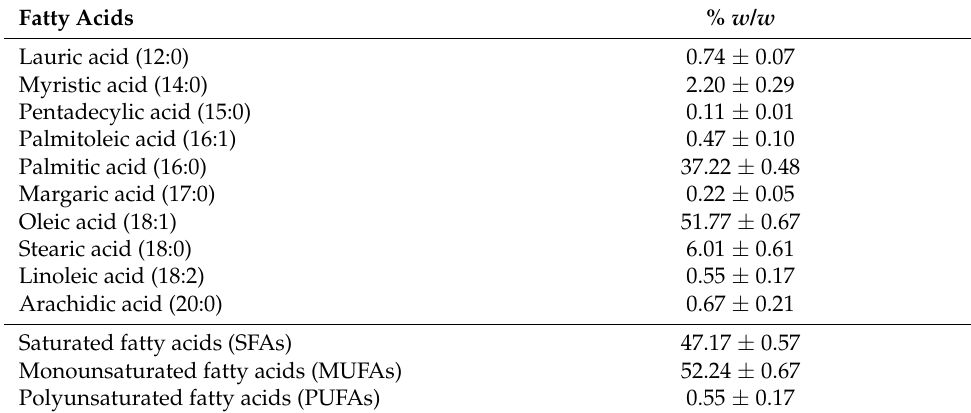
Table 3. Fatty acids composition of palm olein (Morakot brand).